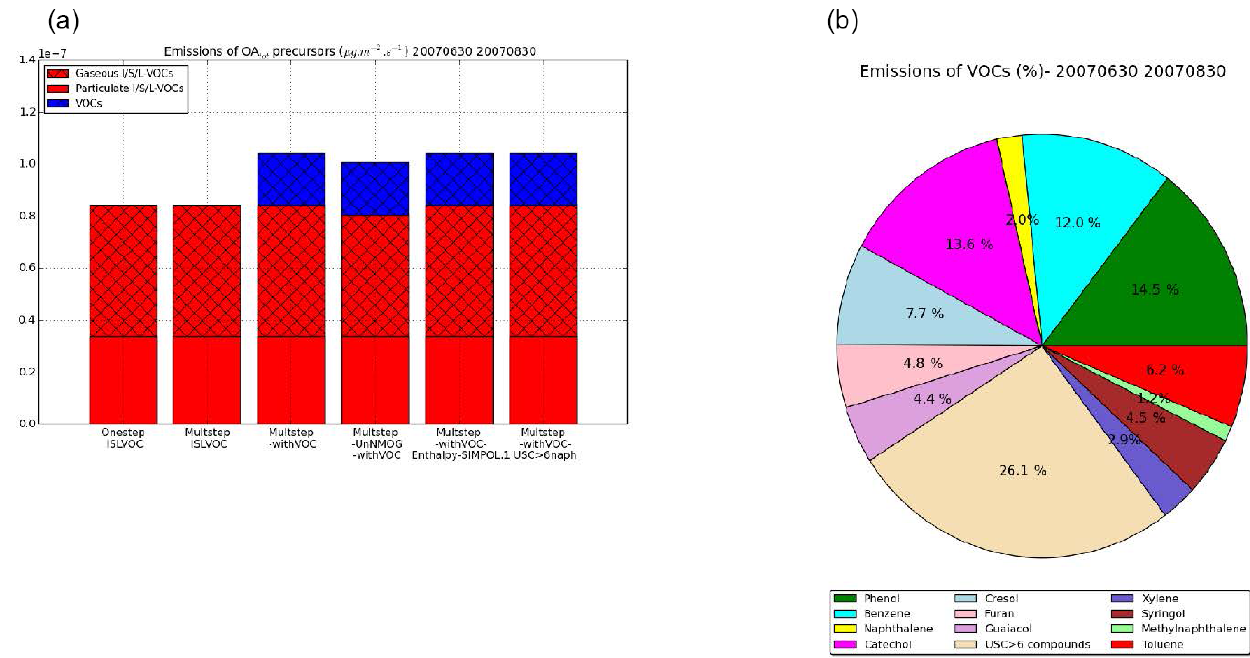
Figure 7. Emissions of the OA tot precursors from wildfires for the different sensitivity simulations (a) and percentage of emissions for each VOC (b) over the subregion during the summer of 2007.